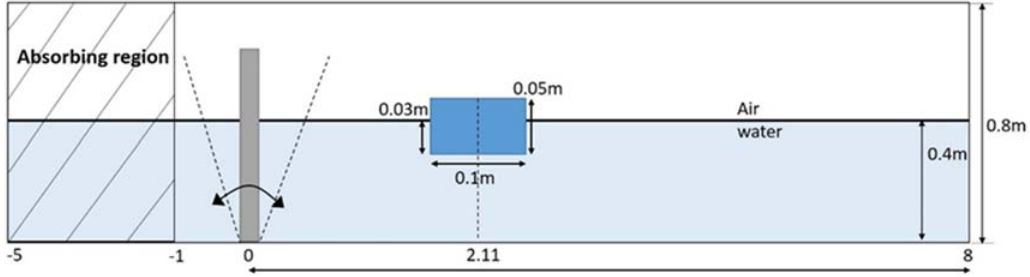
Figure 20. Layout of the freely floating box interacting with a wave packet.